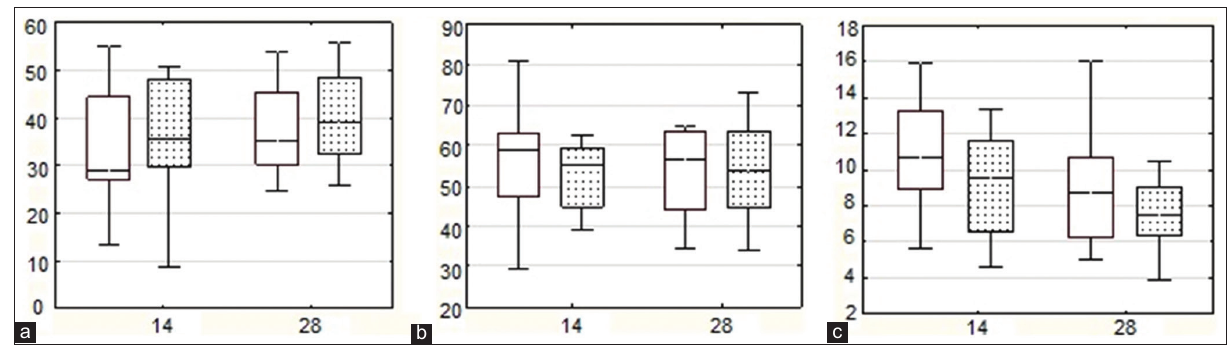
Figure-1: Relative content of lymphocytes (LIM), granulocytes (GRAN), and monocytes (MON) in piglet blood on the 14 th and 28 th days: (a) LIM, %; (b) GRAN, %; (c) MON, %. Data presented as box plots include hinges extending from the 25 th to 75 th percentiles, the median line within the box and whiskers extending to the minimum and maximum values of the dataset. Group 1 – white boxes, Group 2 – boxes with black